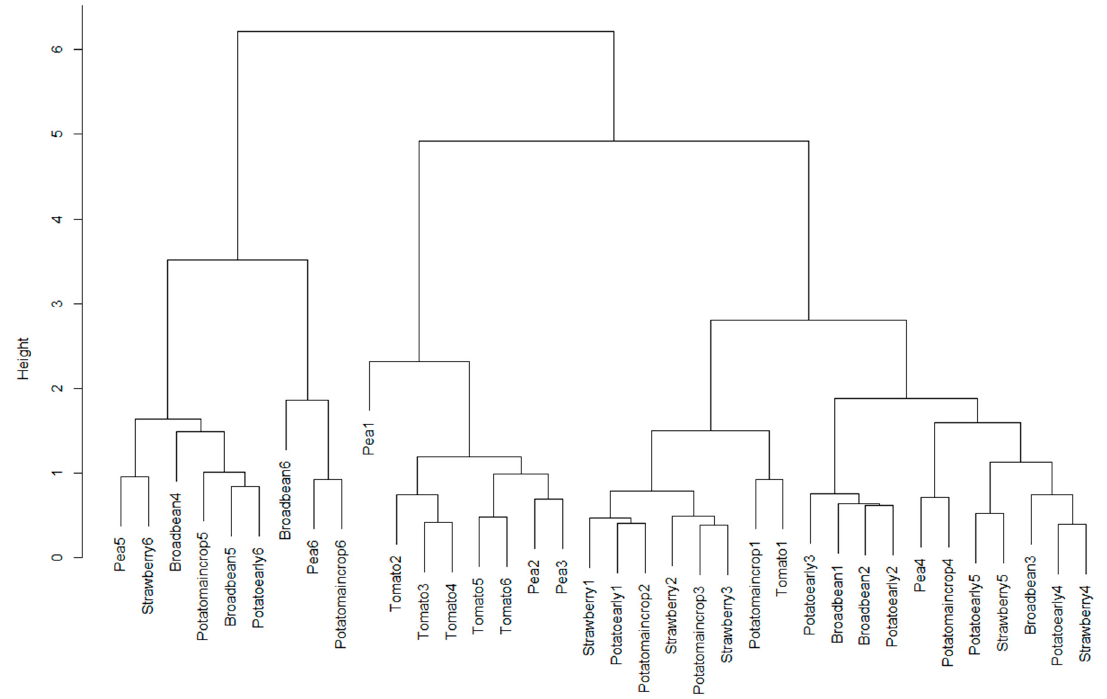
Figure 5. Dendrogram produced for the “no preprocessing” option and variable light levels on vegetable plot samples.